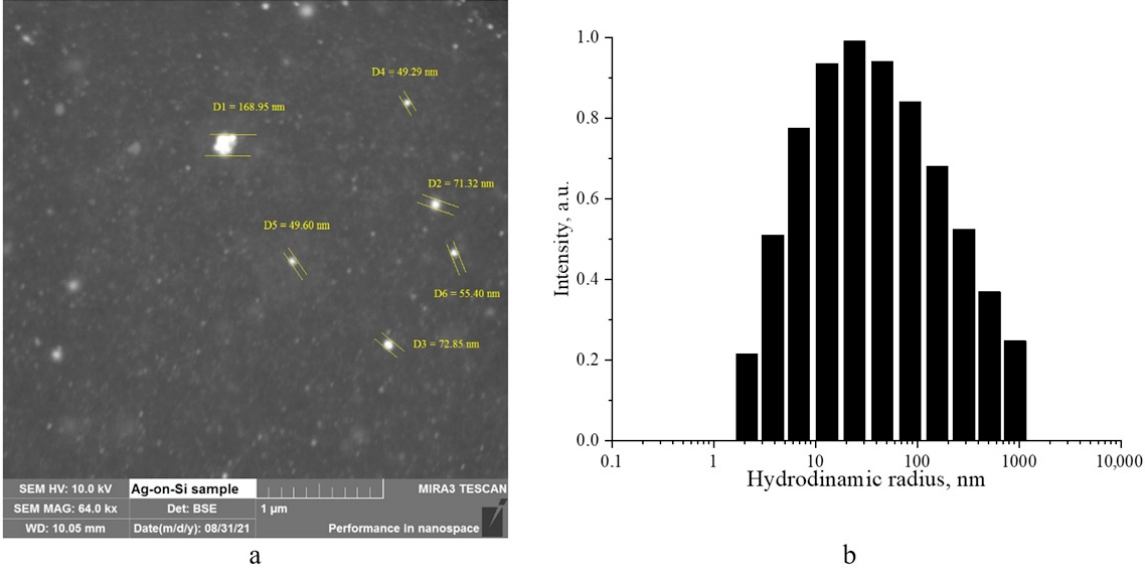
Figure 2. SEM micrograph of a dried sol of silver nanoparticles ( a ), and a histogram of the hydrodynamic radii distribution of silver nanoparticles ( b ).